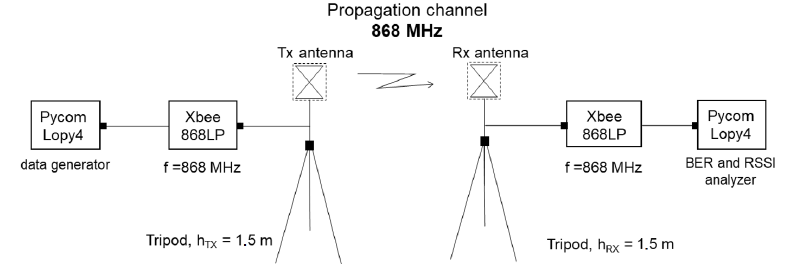
Figure 5. Measurement configuration with Zigbee